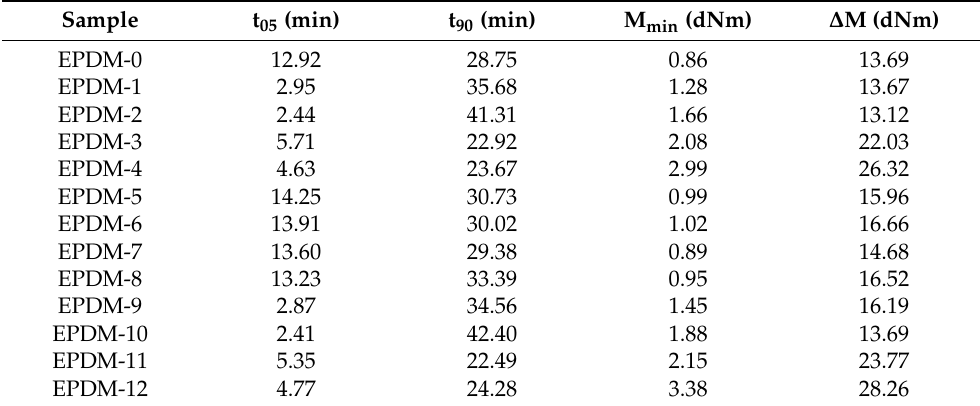
Table 5. Rheometric properties of the EPDM-filled composites.